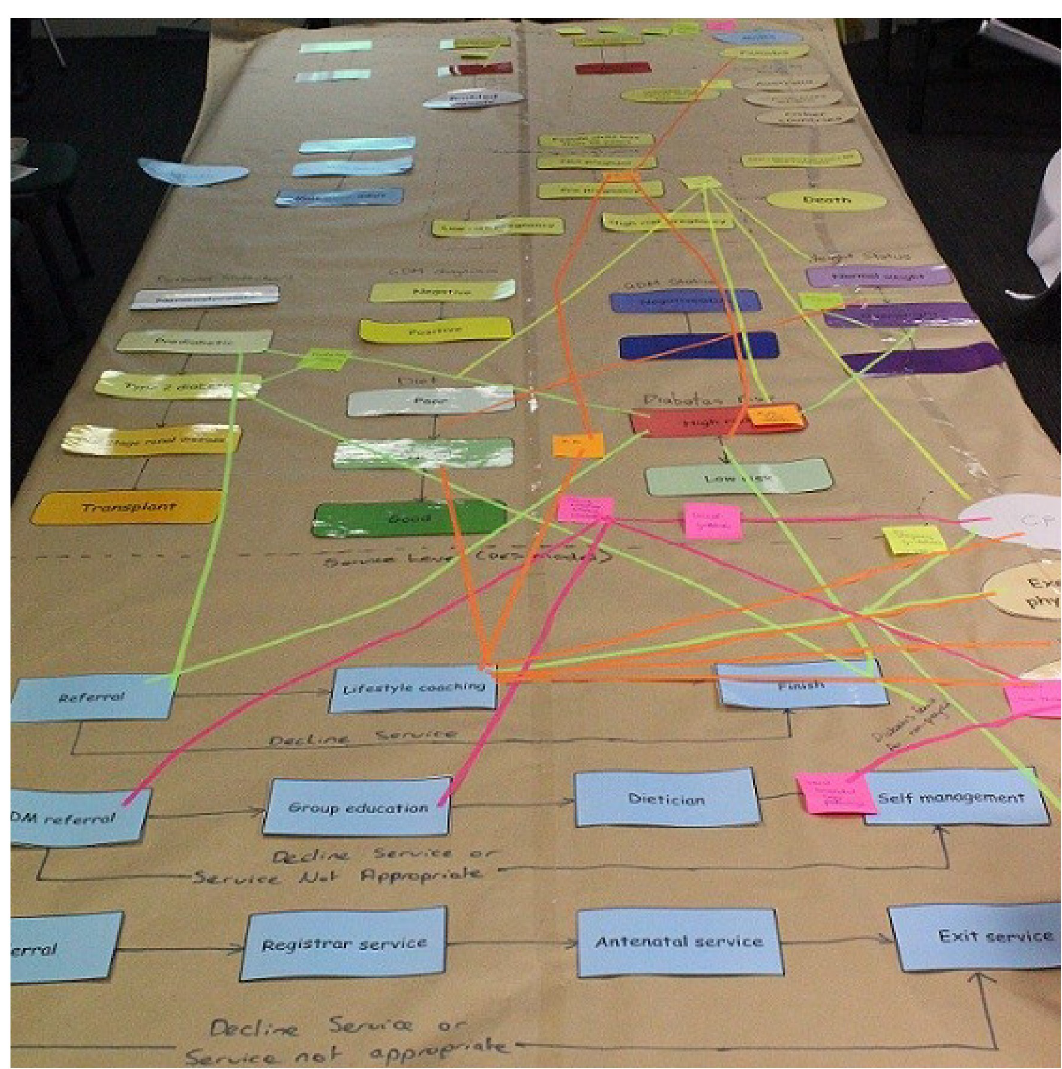
Fig 5. Intervention mapping to model architecture from workshop